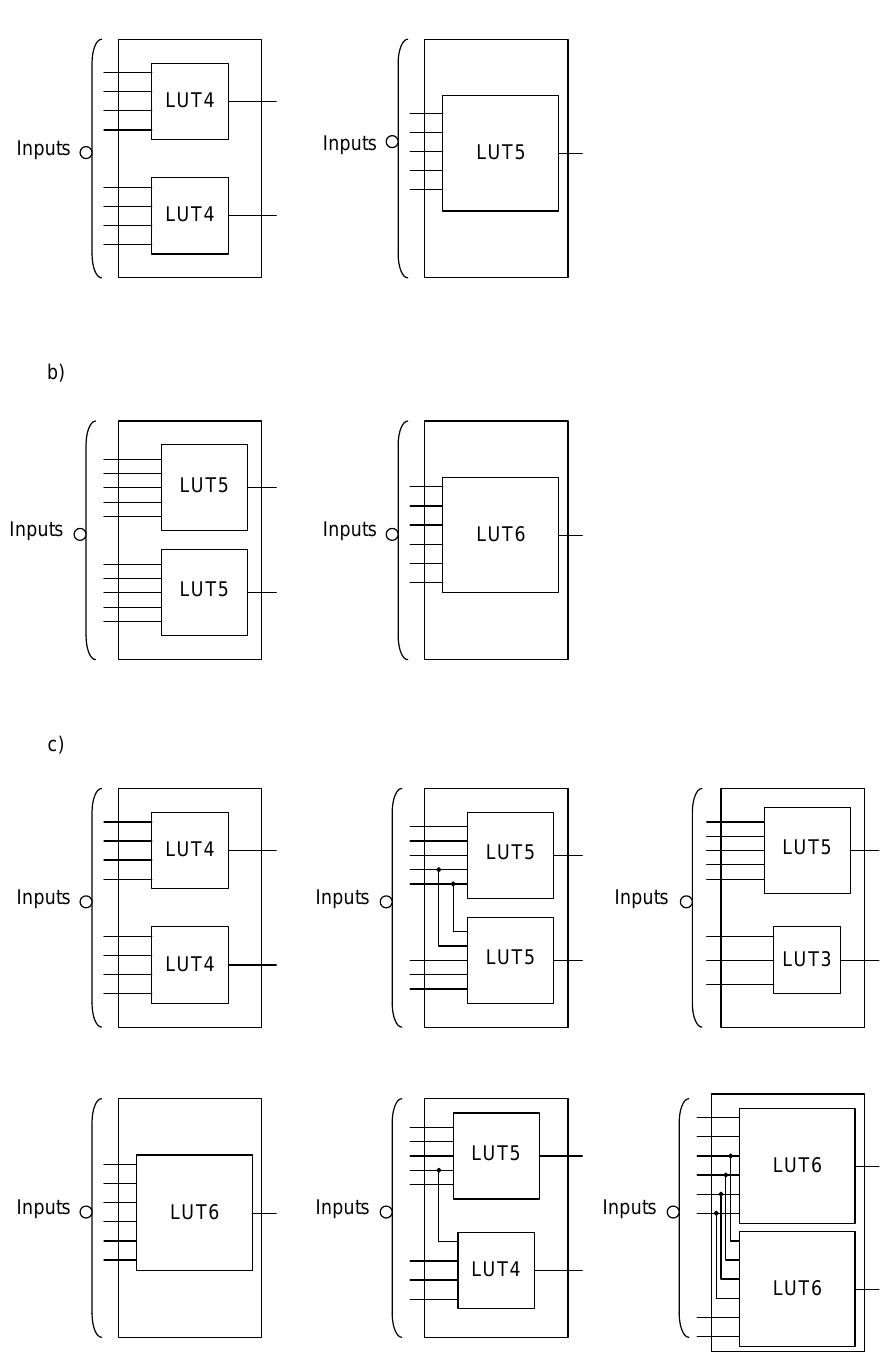
Figure 13. The ability of the configuration logic blocks in FPGA (field-programmable gate array) devices: ( a ) Spartan-3, ( b ) Artix-7, ( c ) Cyclone-10.